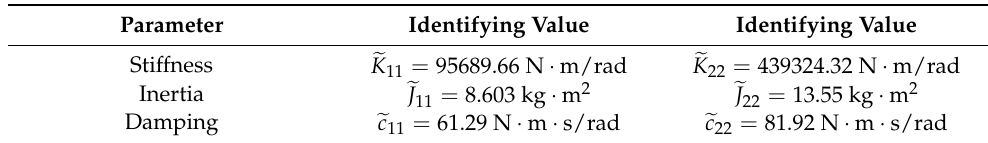
Figure 19. The result of adding two single-degree-of-freedom systems.